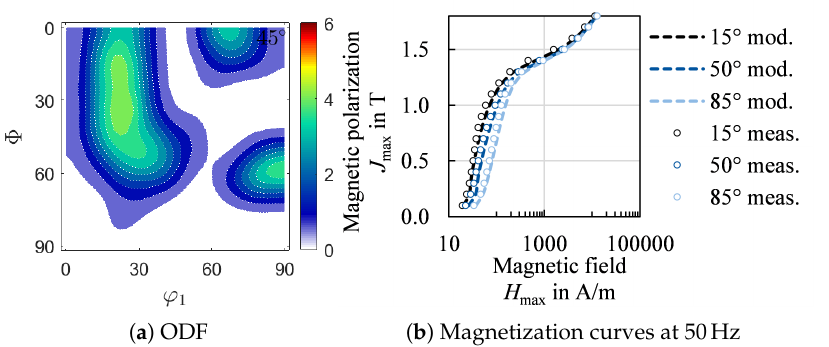
Figure 19. ( a ) Section ϕ 2 = 45° of measured ODF, ( b ) modeled and measured magnetization curves at 50Hz in three directions of the M235-35A